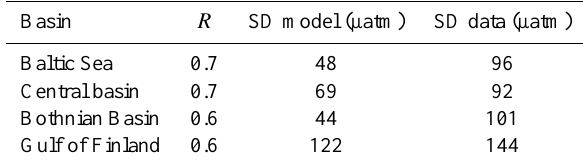
Table 4. Coefficient of correlation ( R ) between the modelled p CO 2 and the p CO 2 data estimated and the SD for the model and the